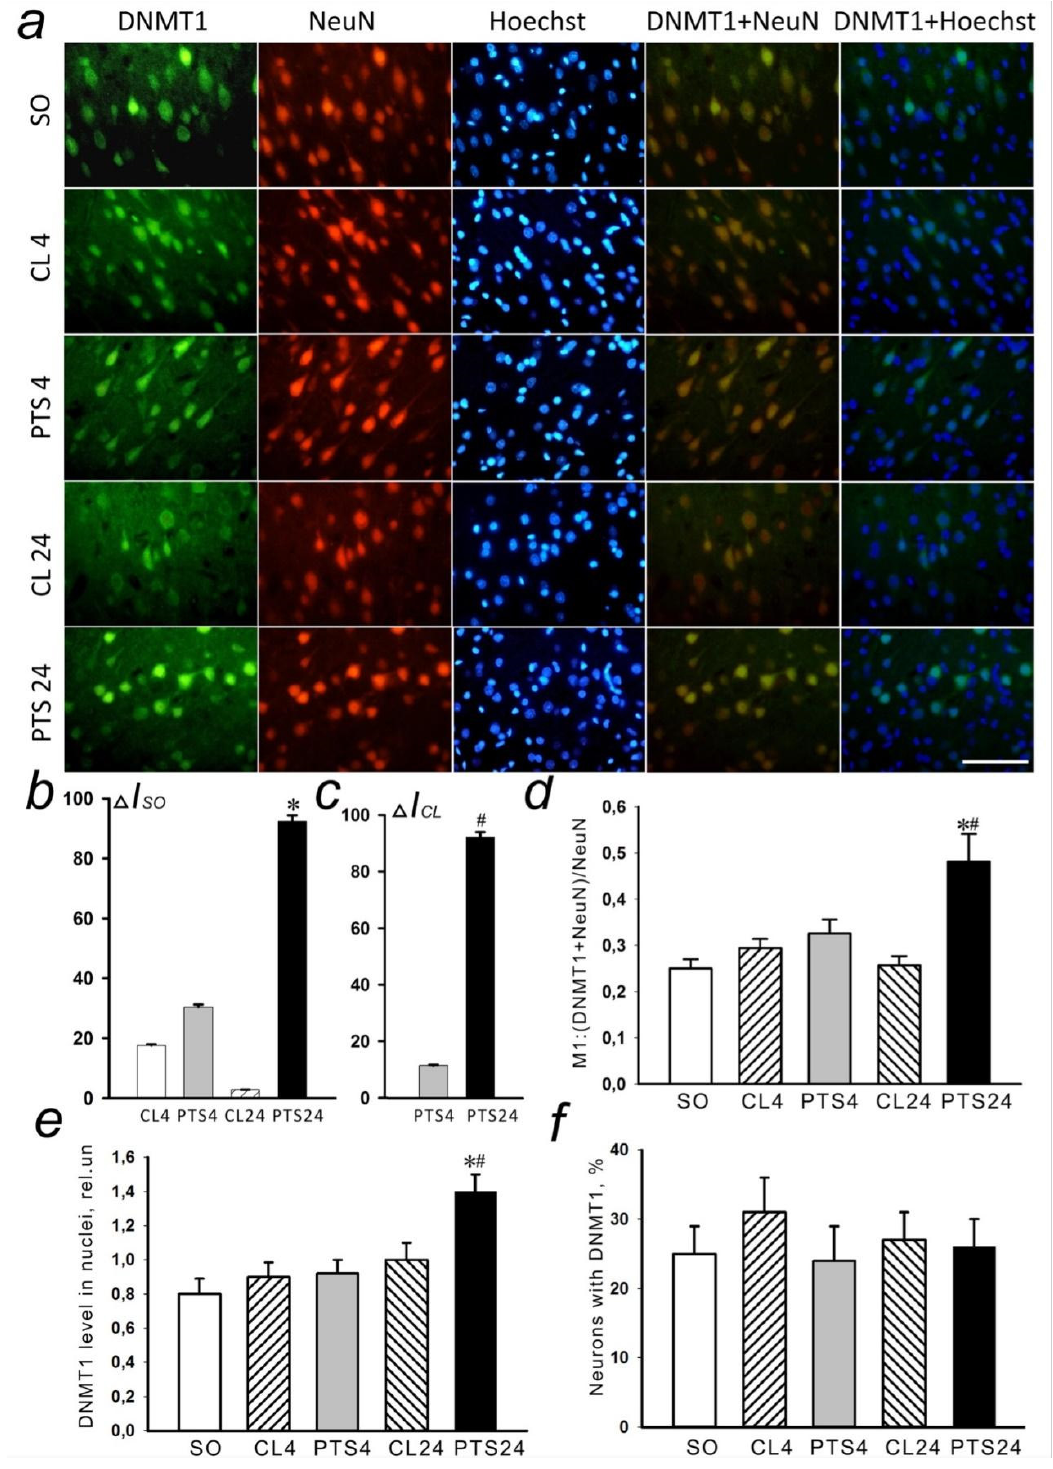
Figure 2. The changes in DNMT1 localization and level in the neurons of ischemic penumbra at 4 and 24 h after photothrombotic stroke (PTS) in the rat cerebral cortex. The significant difference in localization and level of DNMT1 at 4 and 24 h after PTS (PTS4 and PTS24, respectively) is shown compared to the contralateral cortex of the same animals (CL4 and CL24), or the cerebral cortex of sham-operated rats (SO). ( a ) Immunofluorescence of DNMT1 (green), neuronal marker NeuN (red), nuclear chromatin marker Hoechst 33342 (blue), and image overlay. The scale bar is 50 μ m. ( b ) Percent changes ( Δ ISO) of DNMT1 levels in the penumbra (PTS4 or PTS24) and CL4 or CL24 compared to SO at PTS4 or PTS24. ( c ) Percent changes ( Δ ICL) of DNMT1 levels in the penumbra at PTS4 or PTS24 compared to CL4 and CL24. ( d ) Coefficient M1 of DNMT1 co-localization with the neuronal marker (NeuN) in different control and experimental groups. ( e ) Immunofluorescence of DNMT1 in cell nuclei. ( f ) Percentage of cells expressing DNMT1 per 100 cells stained with Hoechst